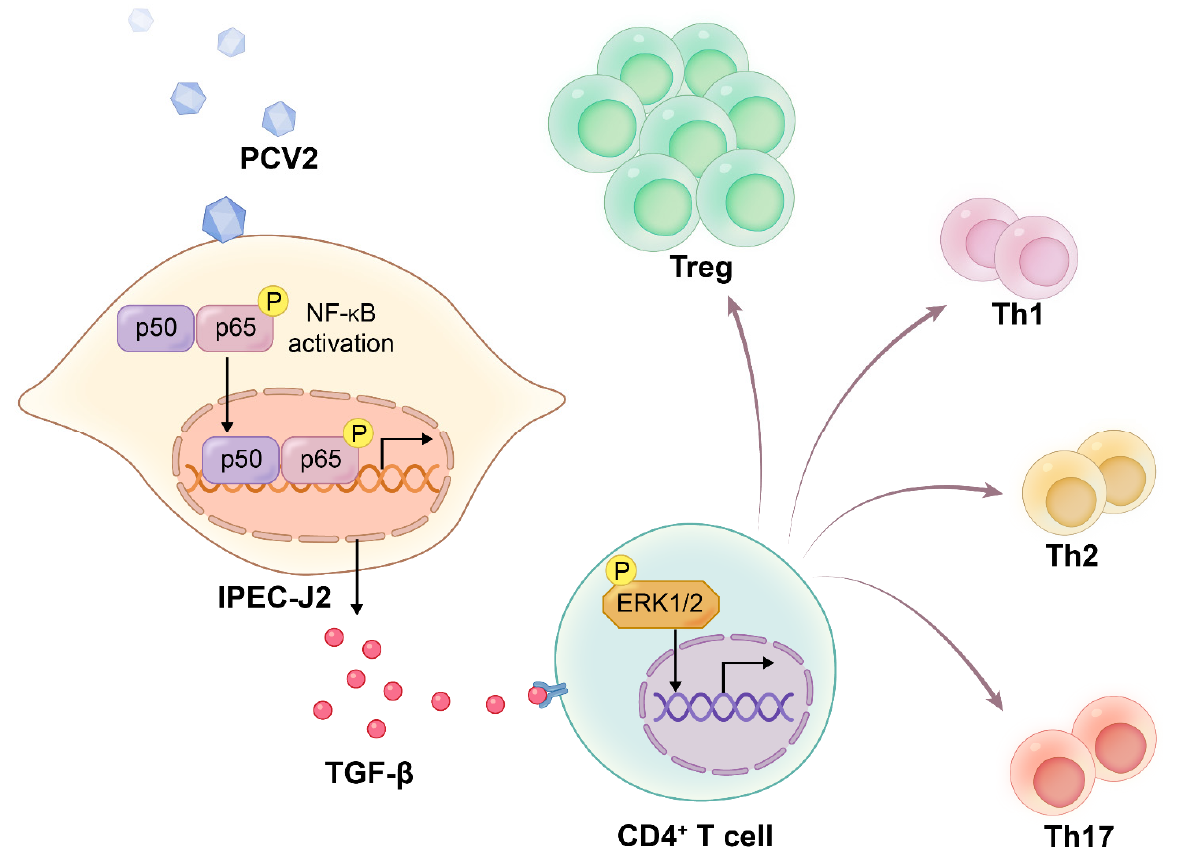
Figure 6. Scheme of PCV2-infected IPEC-J2 increasing the amount of Tregs. The infection of PCV2 on IPEC-J2 activated NF- κ B, which in turn stimulated the production of TGF- β . The activation of ERK in CD4 + T cells was required for TGF- β to be able to promote the differentiation of CD4 + T cells into Treg cells.